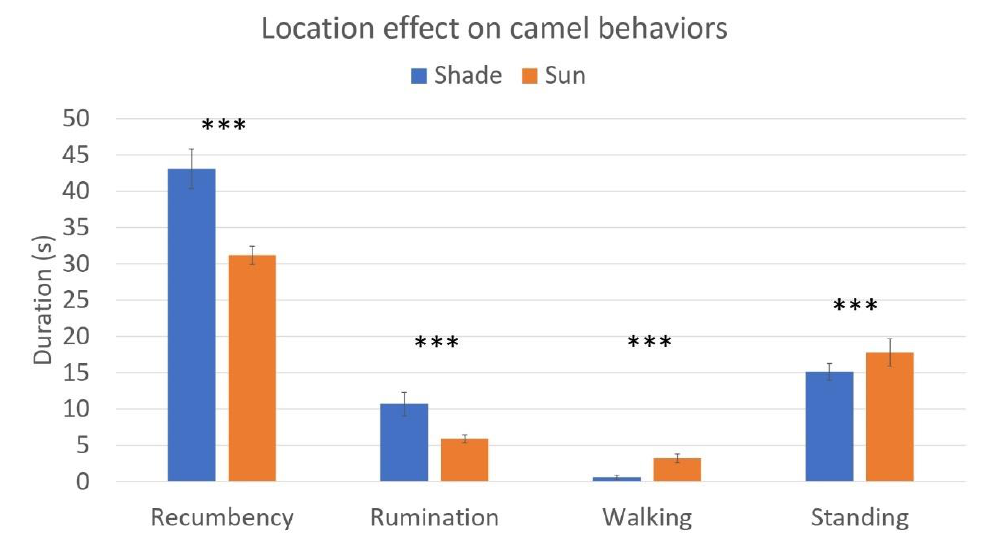
Figure 4. The effect of location (Group 1 shade vs. Group 1 sun) on the duration of recumbency, rumination, walking and standing in camels kept in pens with a shelter (Group 1 shade and Group 1 sun). The means and standard errors are graphically presented. *** means p < 0.001.